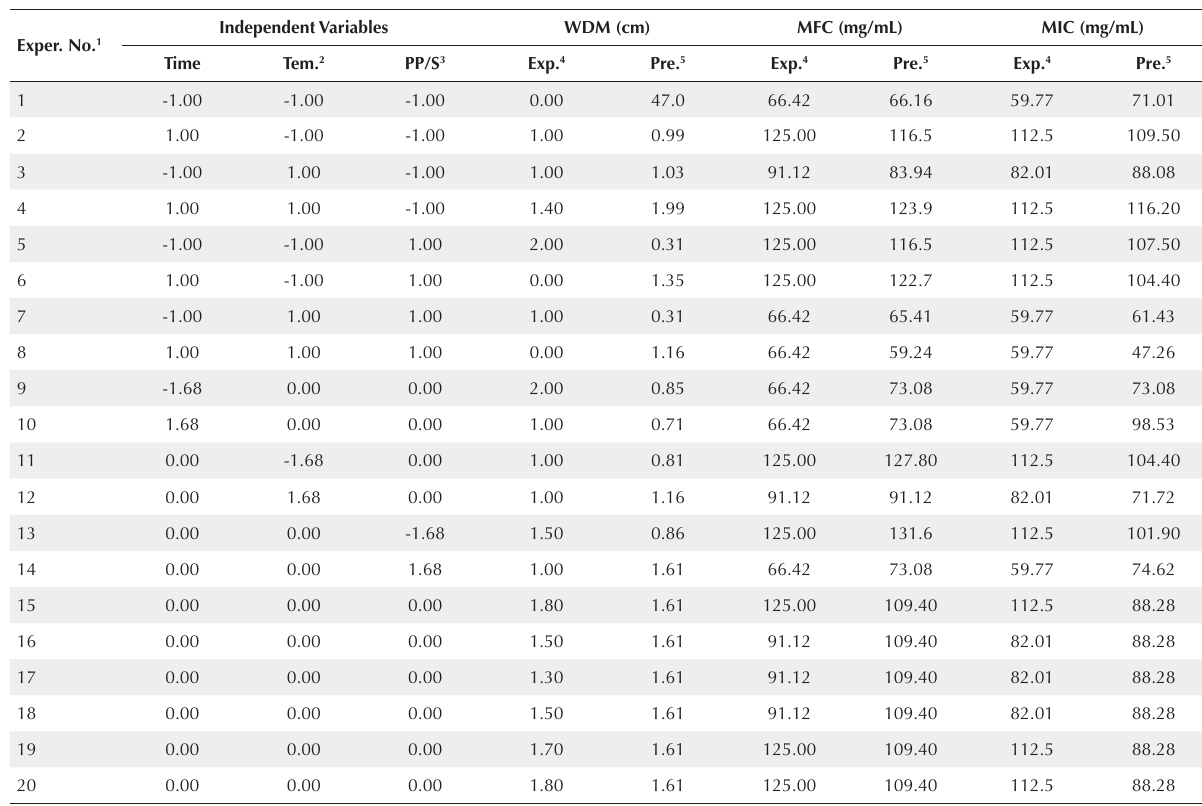
Table 2. Scheme of the central composite rotatable design: independent, predicted, and experimental values of the response variables Exper. No.